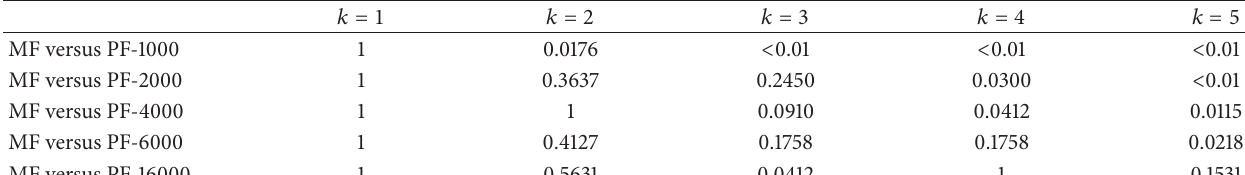
Table 4: The 𝑝 values of the Wald test over the MF and PFs.